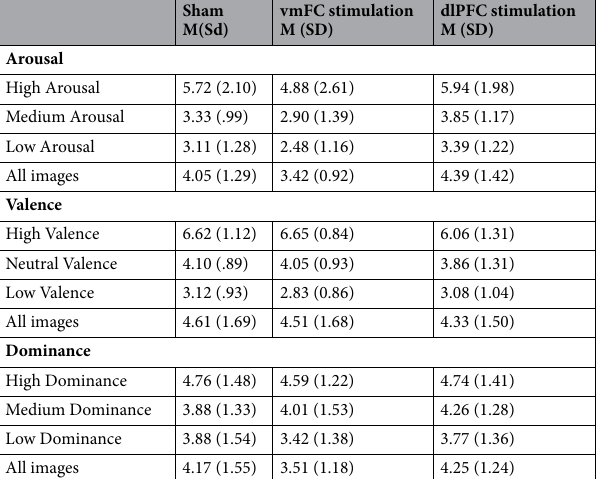
Table 2. Descriptive statistics (mean, standard deviation) for the effects of tDCS on different dimensions of emotional processing. tDCS = transcranial direct current stimulation ; M = mean; sd = standard eviation; vmPFC = ventromedial prefrontal coretx; dlPFC = dorsolateral prefrontal cortex.